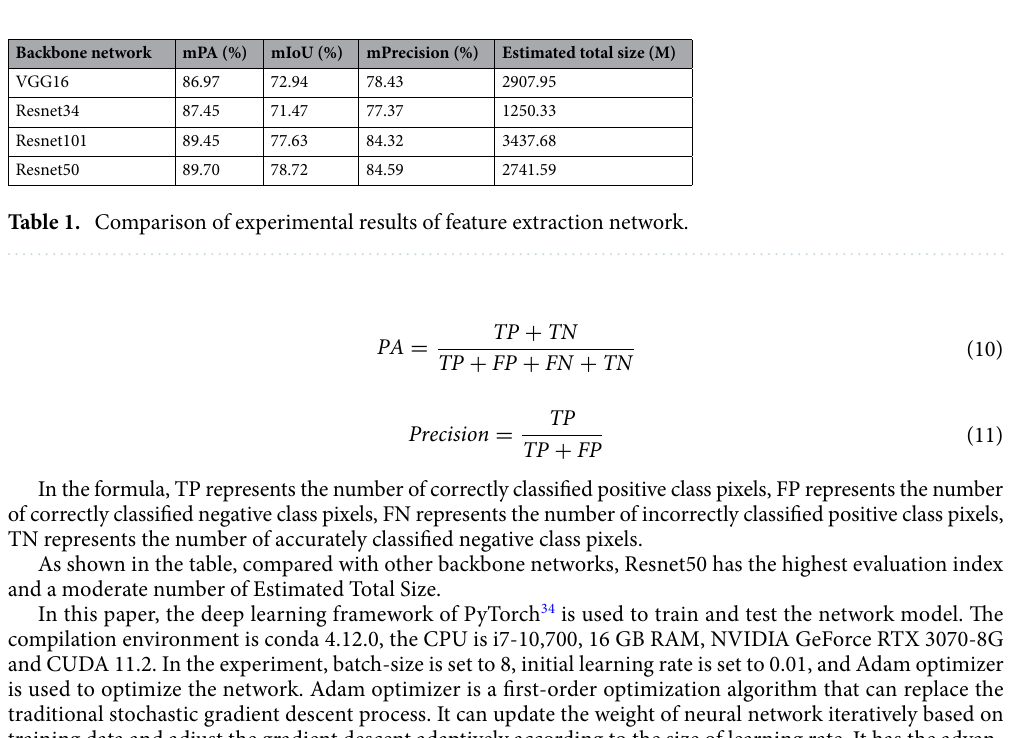
Figure 8. Labels of remote sensing images of different landforms obtained after superpixel segmentation. ( a ) is the original remote sensing image, ( b ) is the result of super pixel segmentation, ( c ) is the label image.